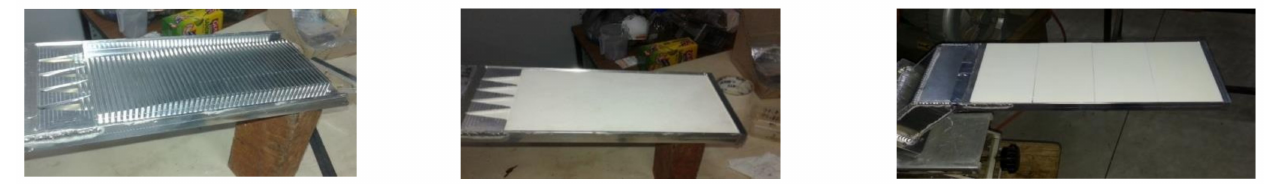
Figure 2. Comb applicator ( left ) and ceramic applicator ( middle ) without ceramic plates, applicator covered with ceramic plates 3 mm × 84 mm × 146 mm—4 pieces ( right